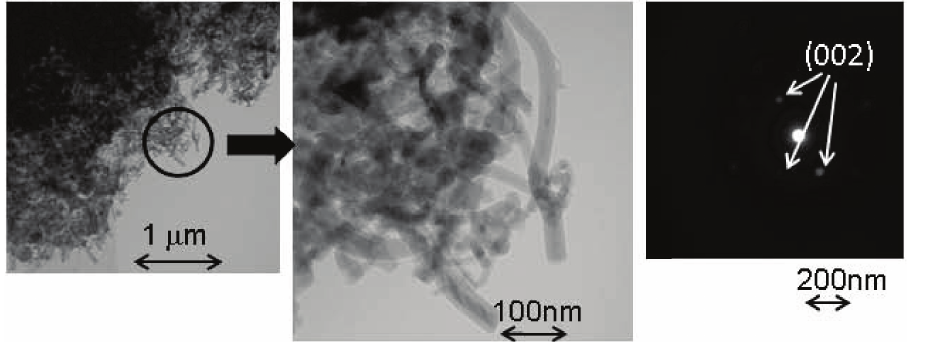
Figure 5. TEM images of the carbonaceous compounds formed on the titanium catalyst. (Left) Overview of the image, (Middle) Image of the circle in the left image with higher resolution, (Right) Electron diffraction pattern obtained from the middle TEM image. The pyrolysis temperature is 1023 K.